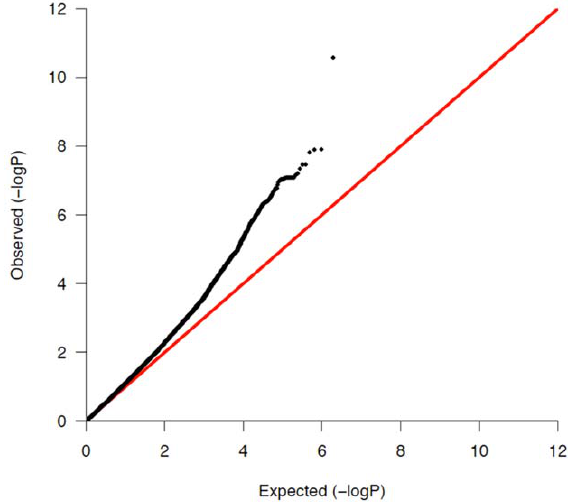
Figure 1. QQ-plot of all previously unassociated regions in the combined meta-analysis discovery